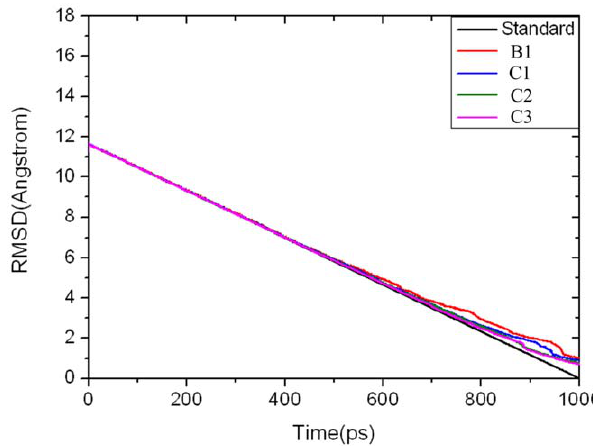
Figure 2. Time evolutions along with the wRMSD of the backbone atoms of GK in the simulated structures compared with the reference structure. Progression of the target wRMSD value is in black; actual values for GK corresponding to the trajectories of B1 and C1-C3 are in red, blue, green, and pink, respectively.